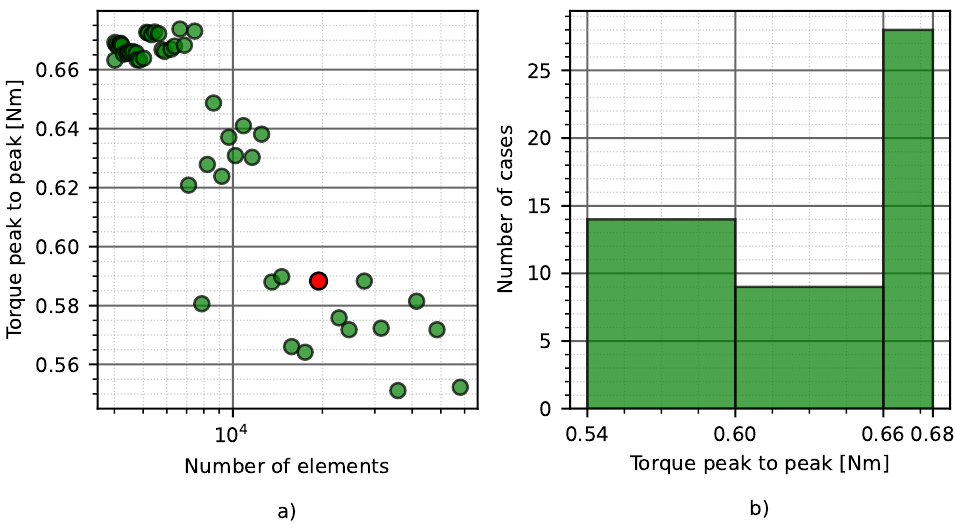
Figure 10. The peak cogging torque in relation to the number of elements. ( a ) The peak cogging torque in each simulation, ( b ) the distribution of the